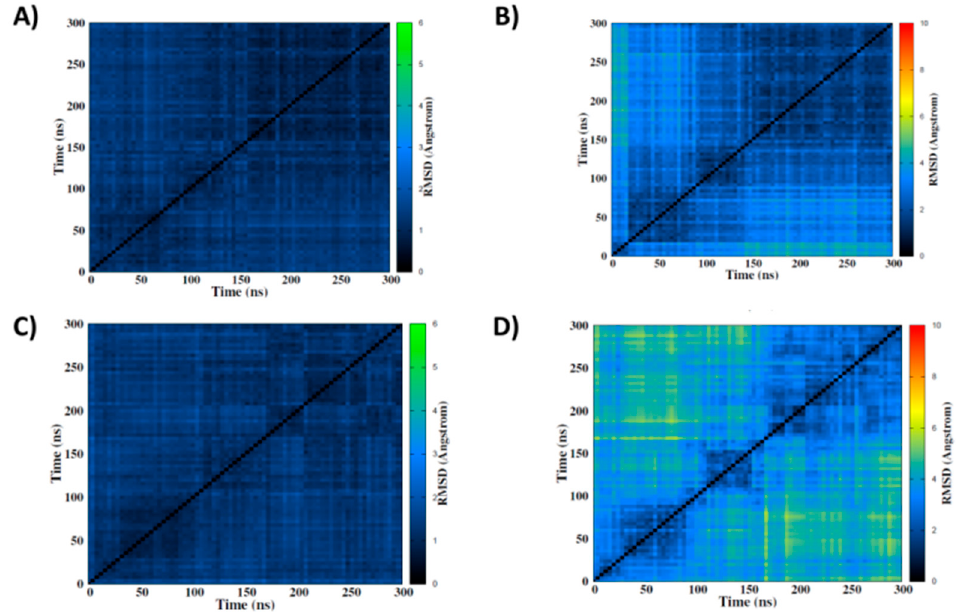
Figure 3. 2D-RMSD maps of simulations of the native structure CA (top) and the 14-15-16 NC (bottom) including the tetrads only ( A , C ) or the whole DNA ( B , D